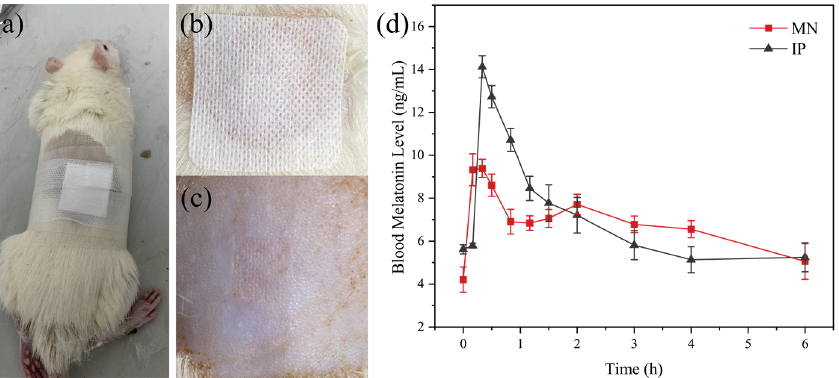
Figure 11. Treatment of insomnia rats with melatonin microneedles: ( a , b ) pictures of a rat treated with MT/SF@MNs, ( c ) pictures of rat skin after removal of MN, and ( d ) curves of blood melatonin concentration over time.